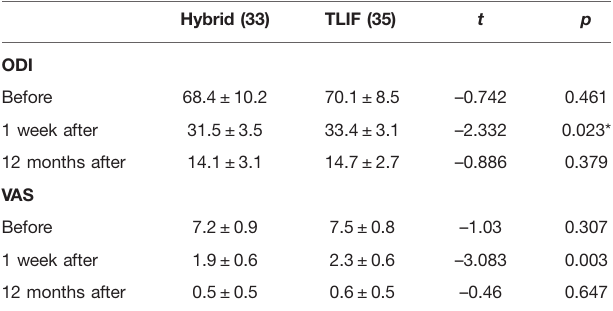
TABLE 5 | Clinical